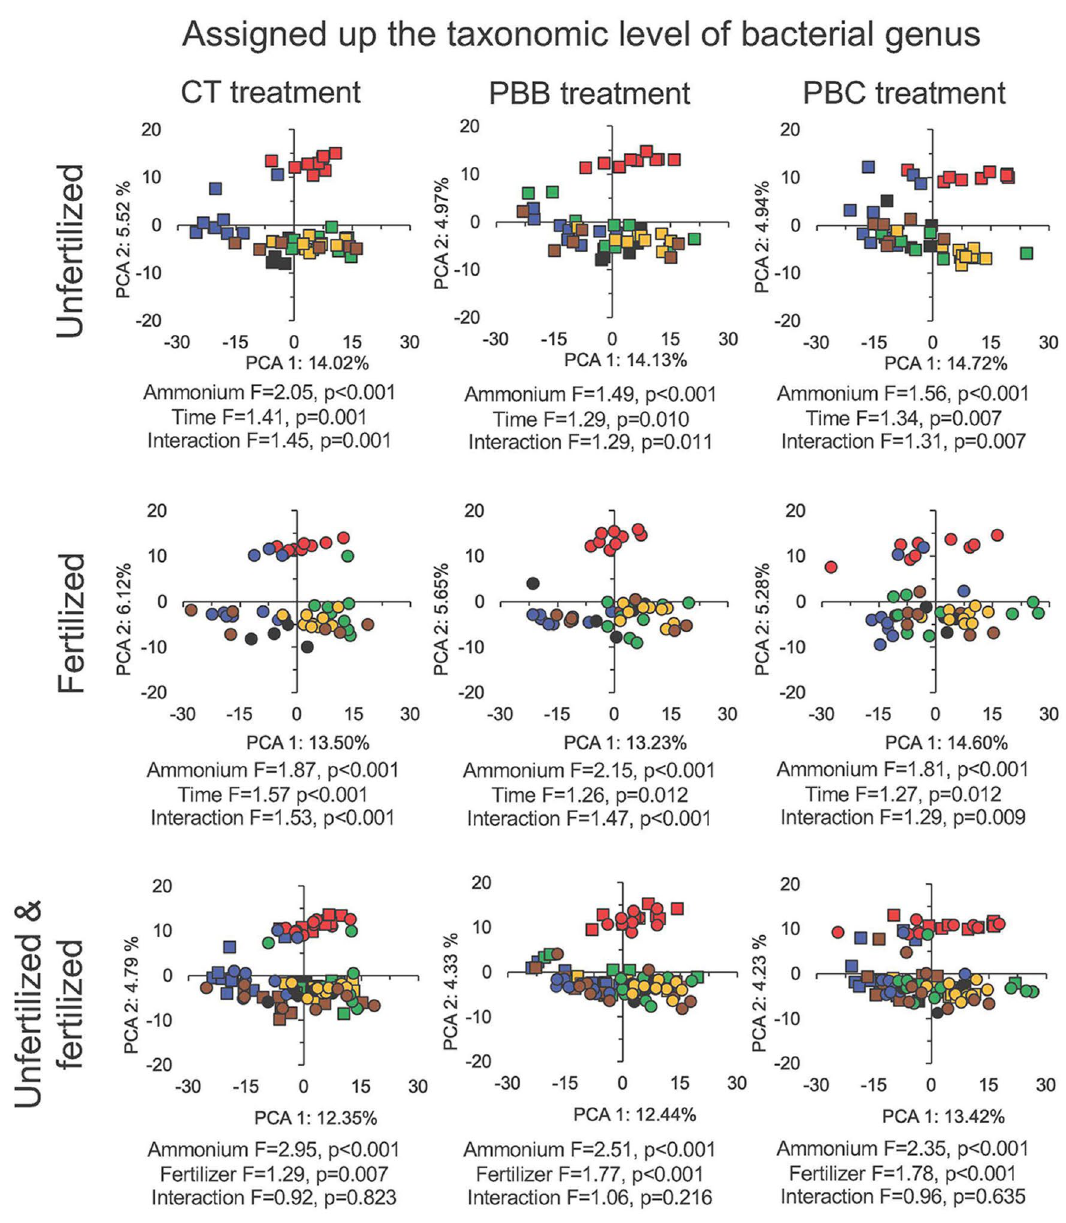
Figure 3. Principal component analysis (PCA) with the converted sequence counts of all bacterial groups classified up to the genus level using the centred log-ratio transformation (aldex.clr argument, ALDEx2 package 14 ) in the unfertilized soil left unamended with permanent beds conventional tilled with residue retained (CT treatment) or permanent beds with crop residue burned (PBB treatment) or permanent beds with crop residue retained (PBC treatment) at day 0, 1 and 3 (filled green square), at day 5, 7 and 14 (filled orange square) and at day 28 and 56 (filled brown square), or ammonium-amended at day 0, 1 and 3 (filled red square), at day 5, 7 and 14 (filled blue square) and at day 28 and 56 (filled black square), and in soil fertilized with 300 kg urea-N ha −1 left unamended at day 0, 1 and 3 (filled green circle), at day 5, 7 and 14 (filled orange circle) and at day 28 and 56 (filled brown circle) or amended with 300 mg NH 4+ -N kg −1 at day 0, 1 and 3 (filled red circle), at day 5, 7 and 14 (filled blue circle) and at day 28 and 56 (filled black circle) incubated aerobically at 25 ± 2 °C for 56 days. F and p values were determined with a perMANOVA Soil functional profiles, and carbon and nitrogen pathway genes. Some clear changes were detected in metabolic processes related to the C and N cycling as determined with FAPROTAX (Figs. S6, S7, S8). Tillage-residue management and application of fertilizer or NH 4+ had a highly significant effect on the carbon and nitrogen pathway genes (Fig. S7). Application of NH 4+ increased the relative abundance of some carbon and nitrogen pathway genes sharply sometimes (Fig. S8). For instance, the relative abundance of the potential ligninolysis showed a large increase in the NH 4+ -amended soil compared to the unamended soil on day 0 and 1